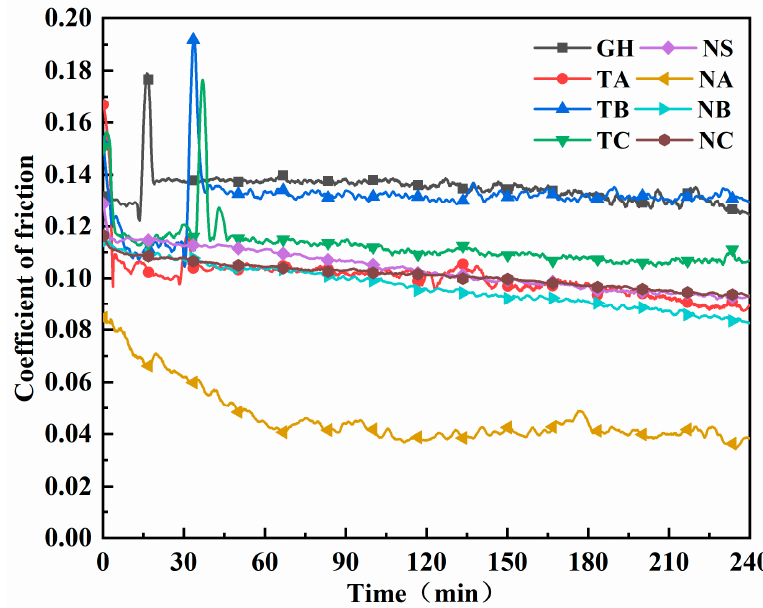
Figure 10. Time–friction coe ffi cient curves for all experimental groups.